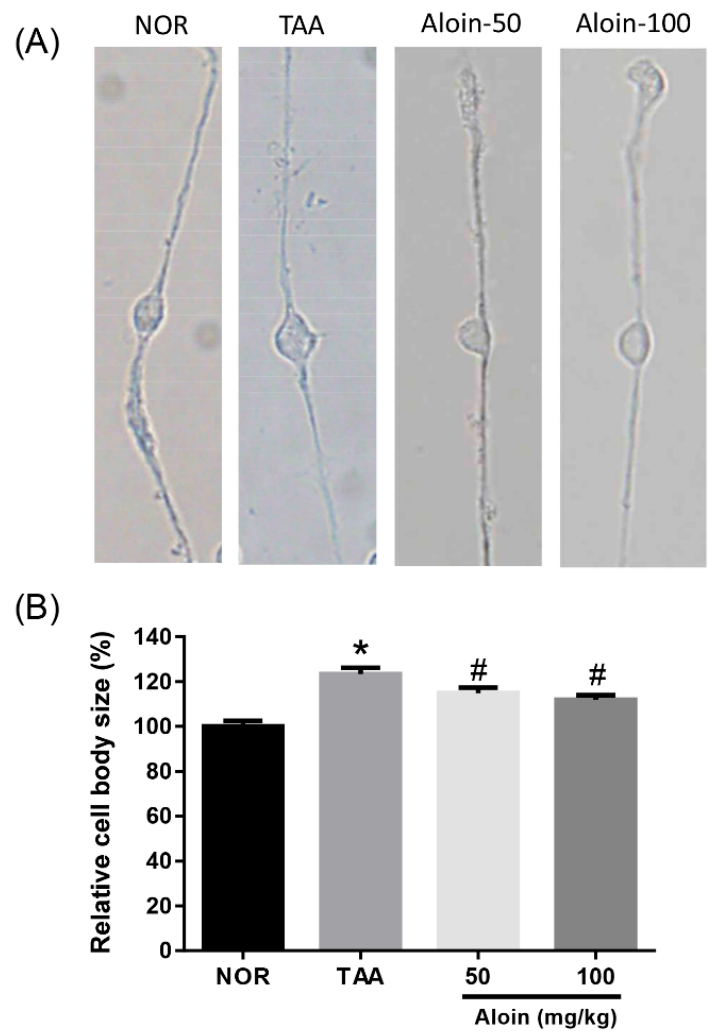
Figure 4. Effect of aloin on Müller cell swelling. ( A ) Enzymatically dissociated Müller cells. ( B ) Quantitative analysis of Müller cell body size. Values in the bar graphs represent the mean ± SEM, n = 7. * p < 0.05 vs. normal control rats, # p < 0.05 vs. TAA-injected rats.